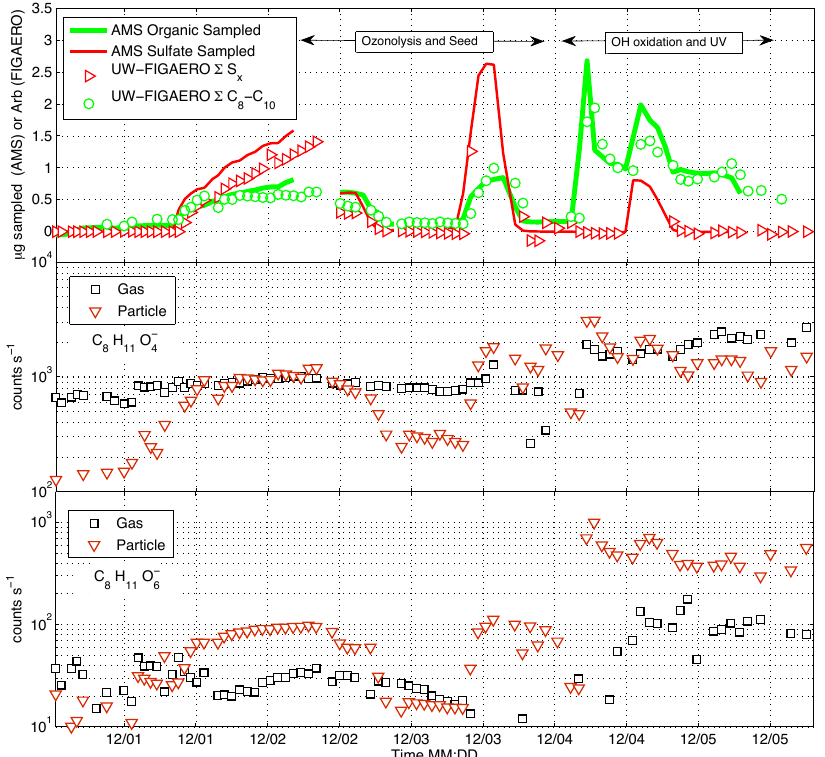
Fig. 8. A time series of the α -pinene oxidation experiments at JPAC. Top: aerosol composition as measured by a HRToF-AMS for bulk organics as well as sulfate (thick green and thin red lines, respectively). FIGAERO data are shown as circles for both the sum of C 8 –C 10 acids and of sulfur containing compounds. During the addition of ammonium sulfate seed the FIGAERO and AMS measure changes in organic aerosol loading and composition. In the lower panels, ion signals for two compounds, C 8 H 11 O − (top) and C 8 H 11 O − (bottom) are 4 6 shown as measured for both gas and particle phases. The C 8 H 11 O − ion signal changes substantially during the switch from ozonolysis to 6 OH oxidation. For the C 8 H 11 O − compound, the addition of seed significantly increases its detection in the particle phase, while oxidation 4 by OH dampens the effect of seed on its